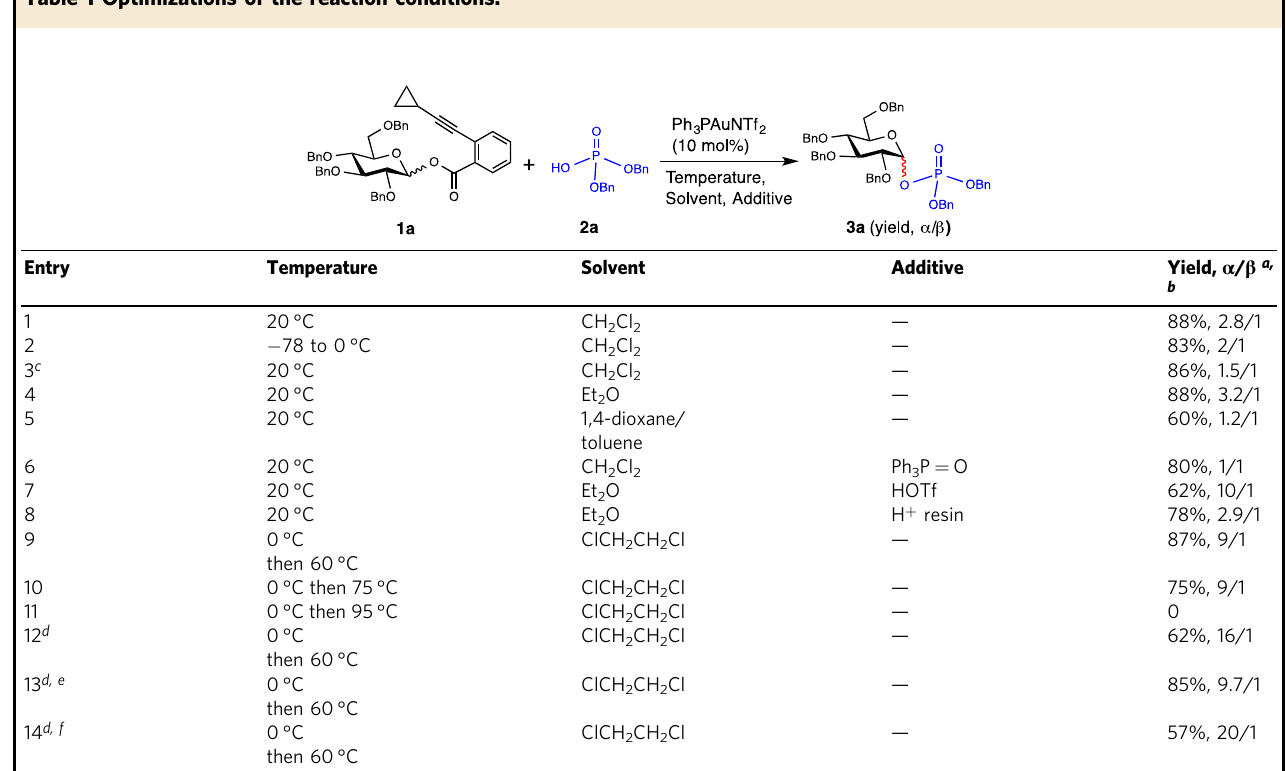
Table 1 Optimizations of the reaction